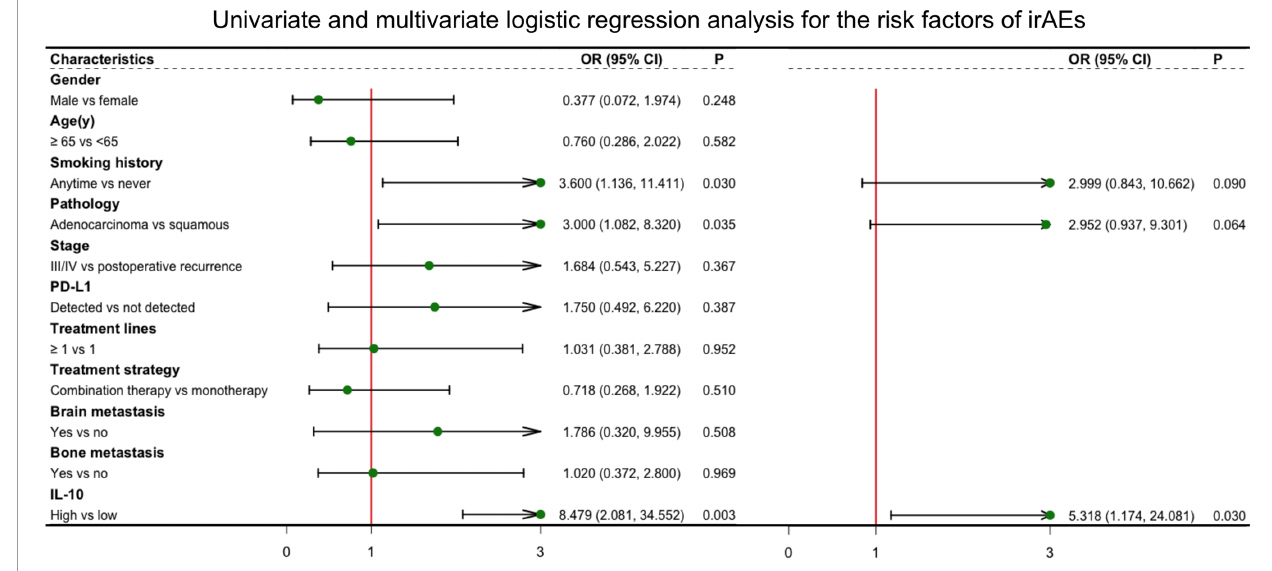
FIGURE 3 | Logistic regression with univariate and multivariate analyses for the risk factors of irAEs. Characteristics in univariate models with p-value <0.05 were included in multivariate analysis. irAEs, immune-related adverse